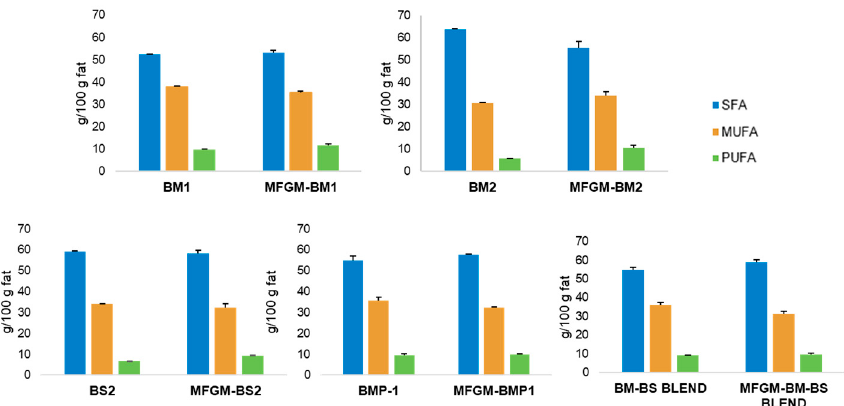
Figure 5. Distribution of saturated fatty acid (SFA), monounsaturated fatty acid (MUFA), and polyunsaturated fatty acid (PUFA) content (values expressed as g/100g of fat ± standard derivation) of the selected samples and their corresponding MFGM isolates.